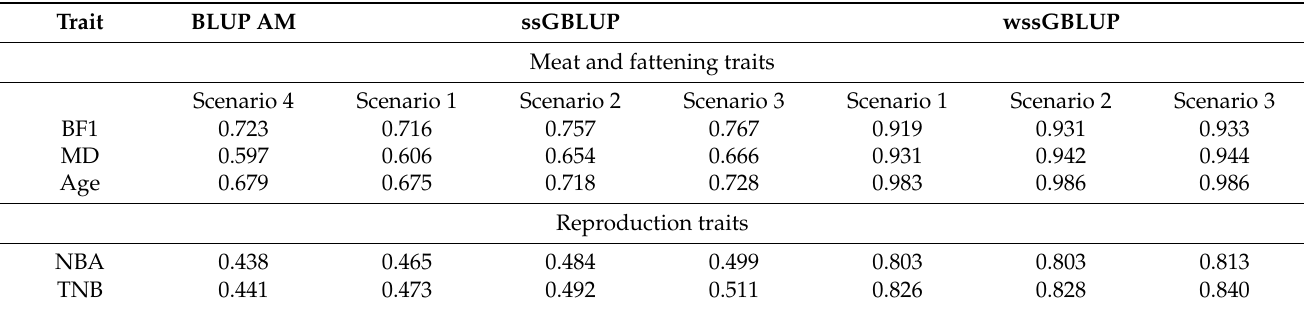
Table 4. Average animal estimate reliability of the first and fourth reference groups (530 and 396 animals), depending on the method and amount of genomic